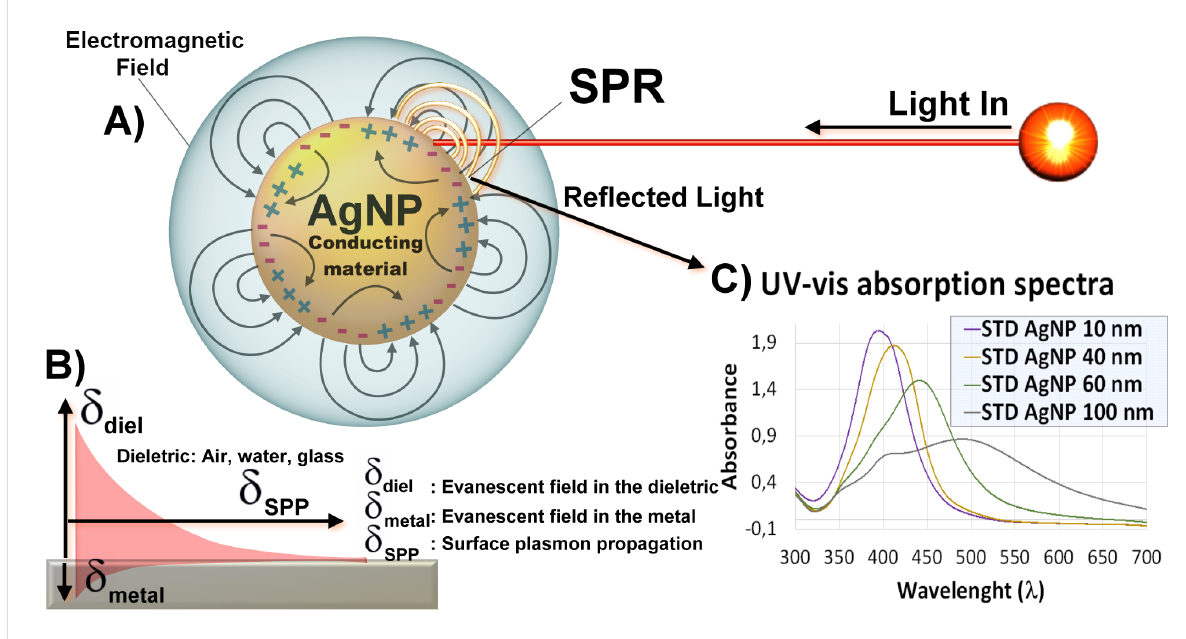
Figure 5: (A) Propagation of surface plasmon resonance in spherical AgNPs during their interaction with the electromagnetic radiation. (B) The order of magnitude of the plasmon lengths in SPR. (C) UV–vis absorption spectra of spherical silver nanoparticle standards with sizes of 10, 40, 60, and 100 nm, respectively, all with a concentration of 0.02